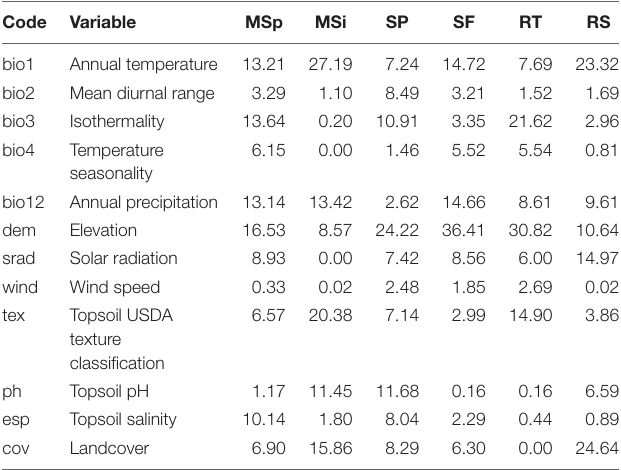
TABLE 2 | Ecological variables and their relative percentage contributions in the Maxent